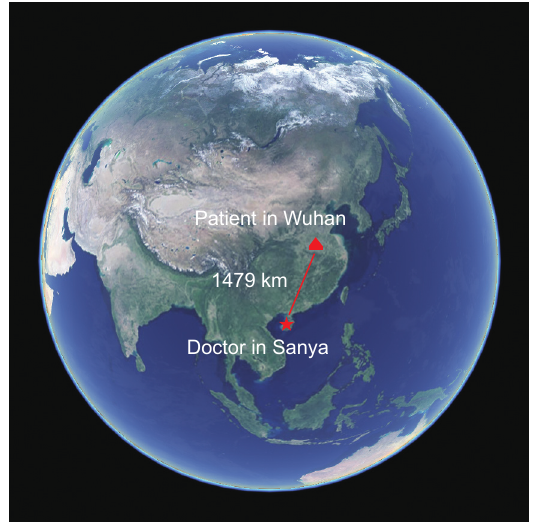
Figure 2 Performance of robot-assisted teleultrasound base on 5G network. (A) An ultrasound expert on the doctor-side was controlling the duplicate operation panel of an ultrasound instrument and a handheld controller to manipulate the robotic arm, with the aid of the audio-video system; (B) The patient-side subsystem was placed bedside. The robotic arm handling a probe was scanning on the right anterior chest wall for lung ultrasound.